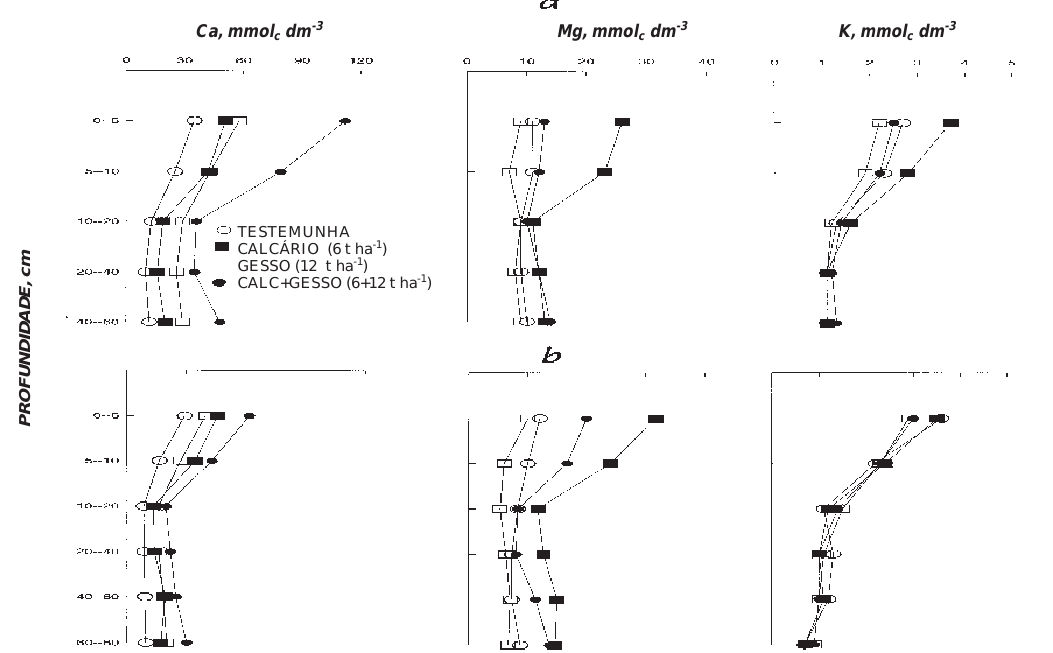
Figura 3. Efeito da calagem, após 12 e 28 meses(a), e da aplicação de gesso, após 8 e 24 meses(b), sobre os teores de Ca, Mg e K trocáveis, em diferentes profundidades. Média de 3